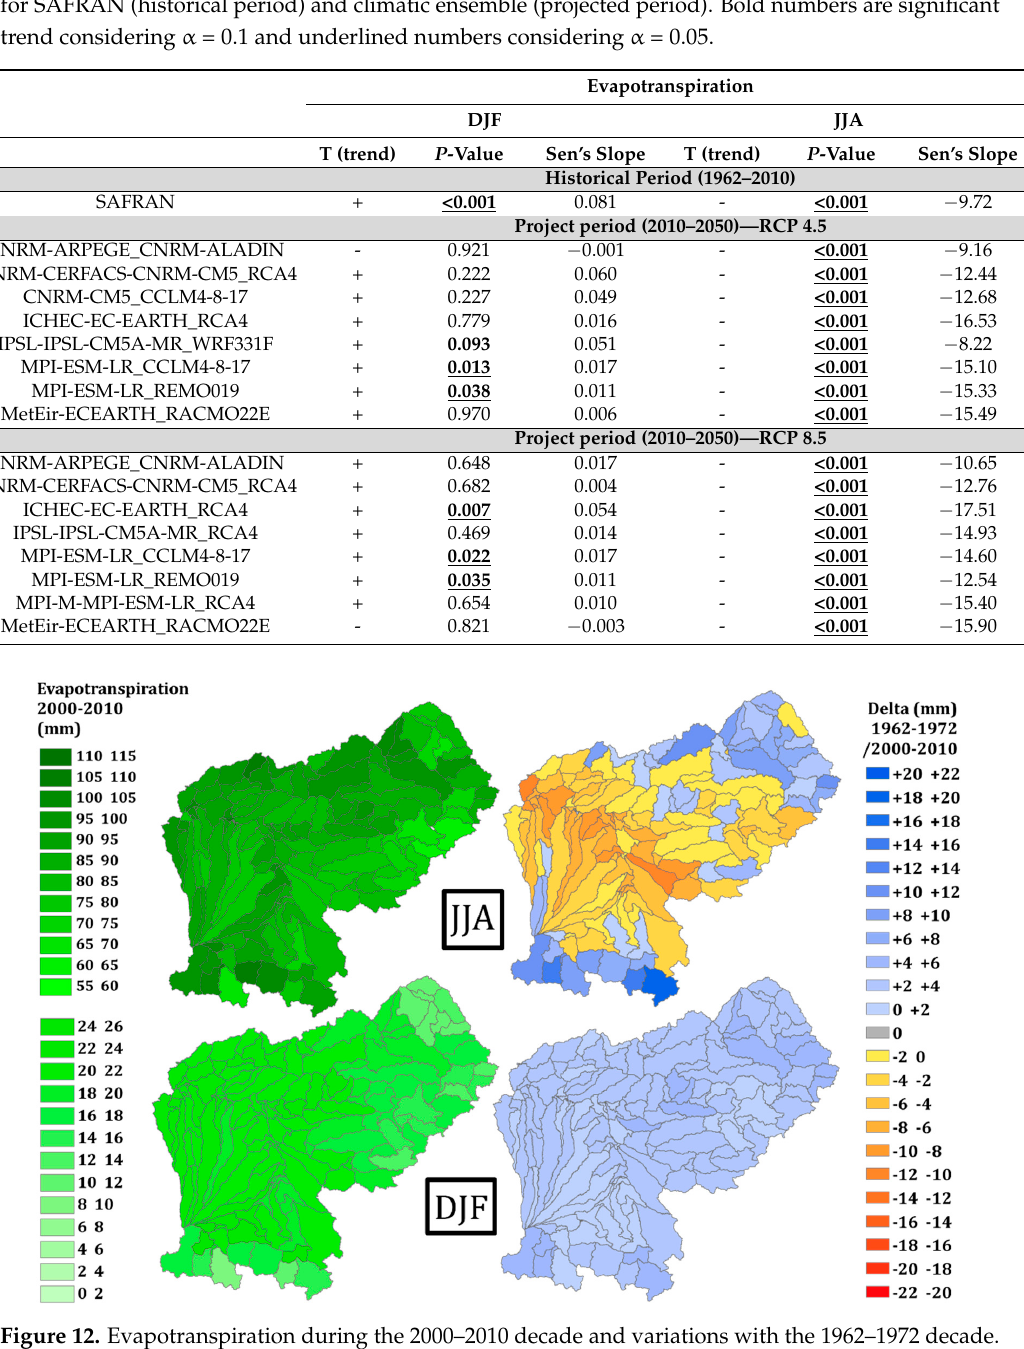
Figure 12. Evapotranspiration during the 2000–2010 decade and variations with the 1962–1972